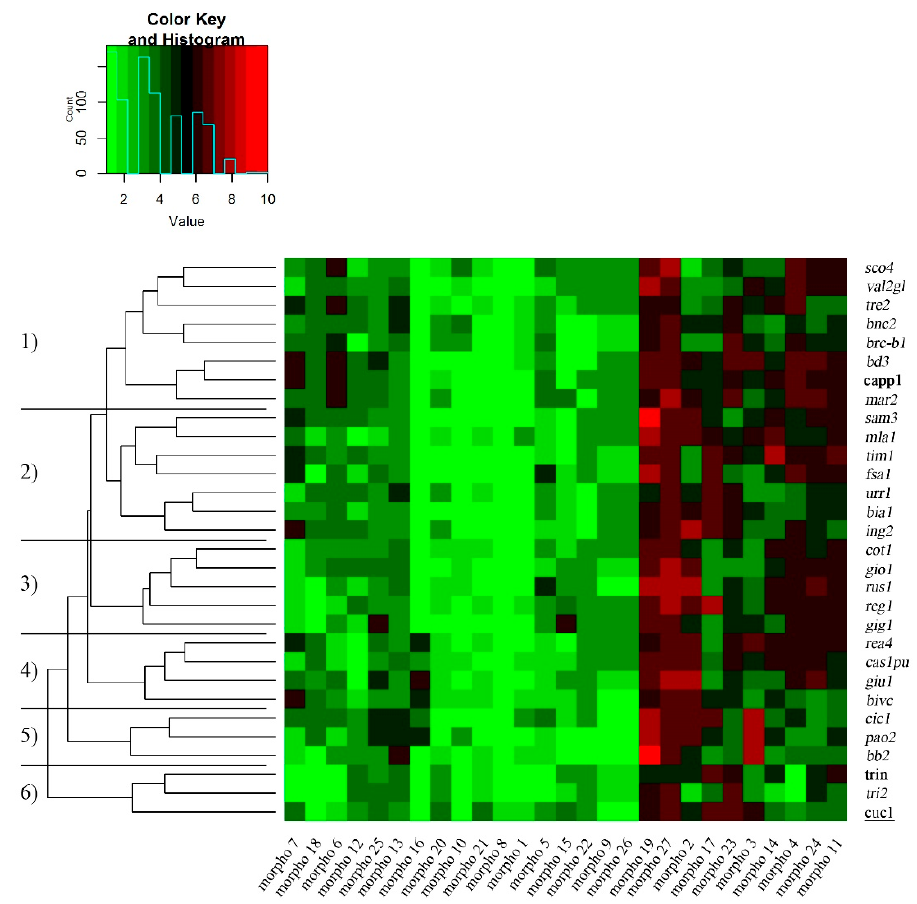
Figure 1. Heatmap of the morphological traits measured on Sicilian wheat germplasm (27 landraces; in italic), 2 historical varieties (Cappelli and Trinakria; in bold) and 1 bread wheat landrace (Cuccitta; underlined). Green and red colors represent reduced and augmented representation levels, respectively. Hierarchical clustering of samples (cluster 1–6) and traits are also shown. All the traits, coded as morpho 1 to morpho 27, are described in Table S1.